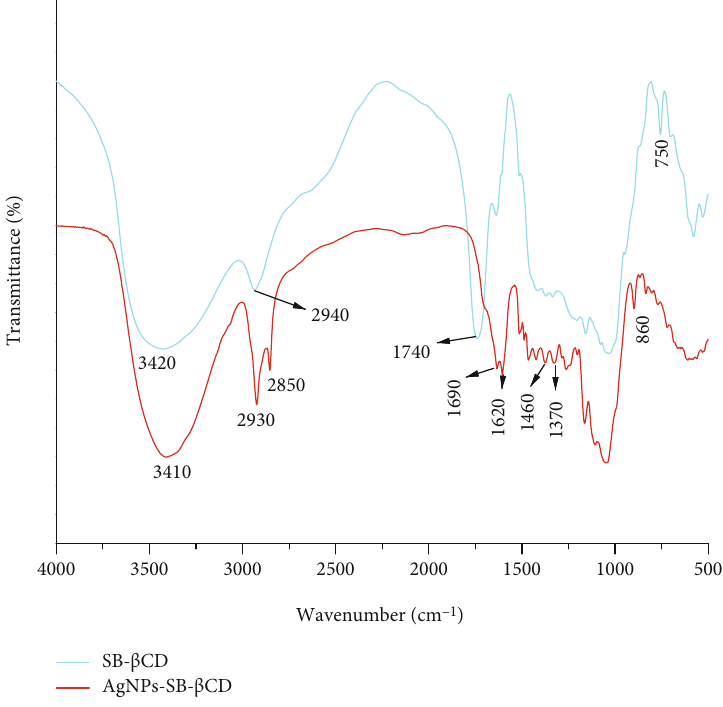
Figure 2: FTIR spectra of SB- β CD polymer and AgNP-SB- β CD